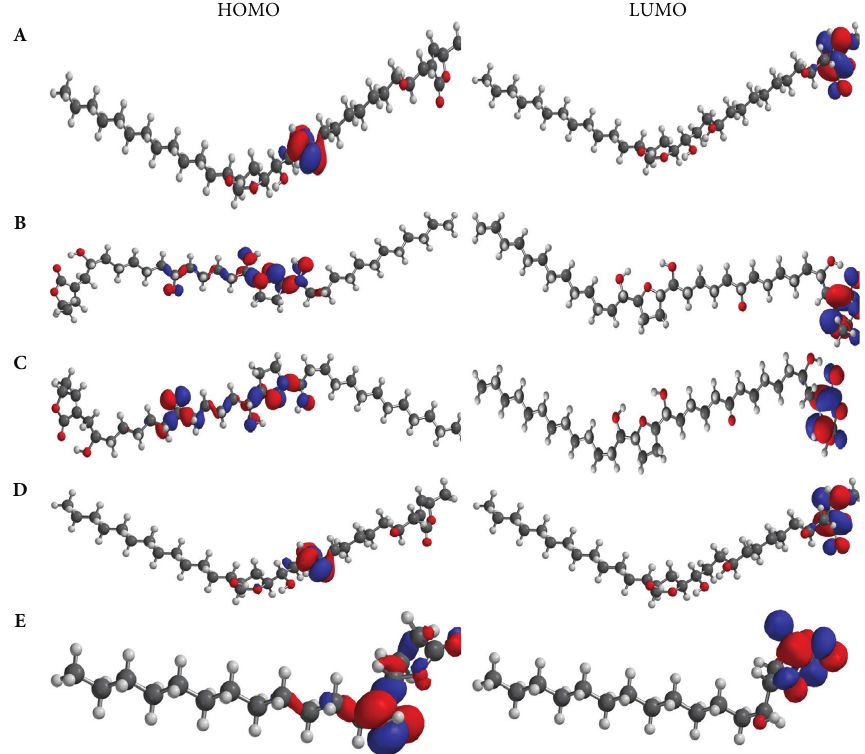
Figure 2: Studied E HOMO - E LUMO overlay.